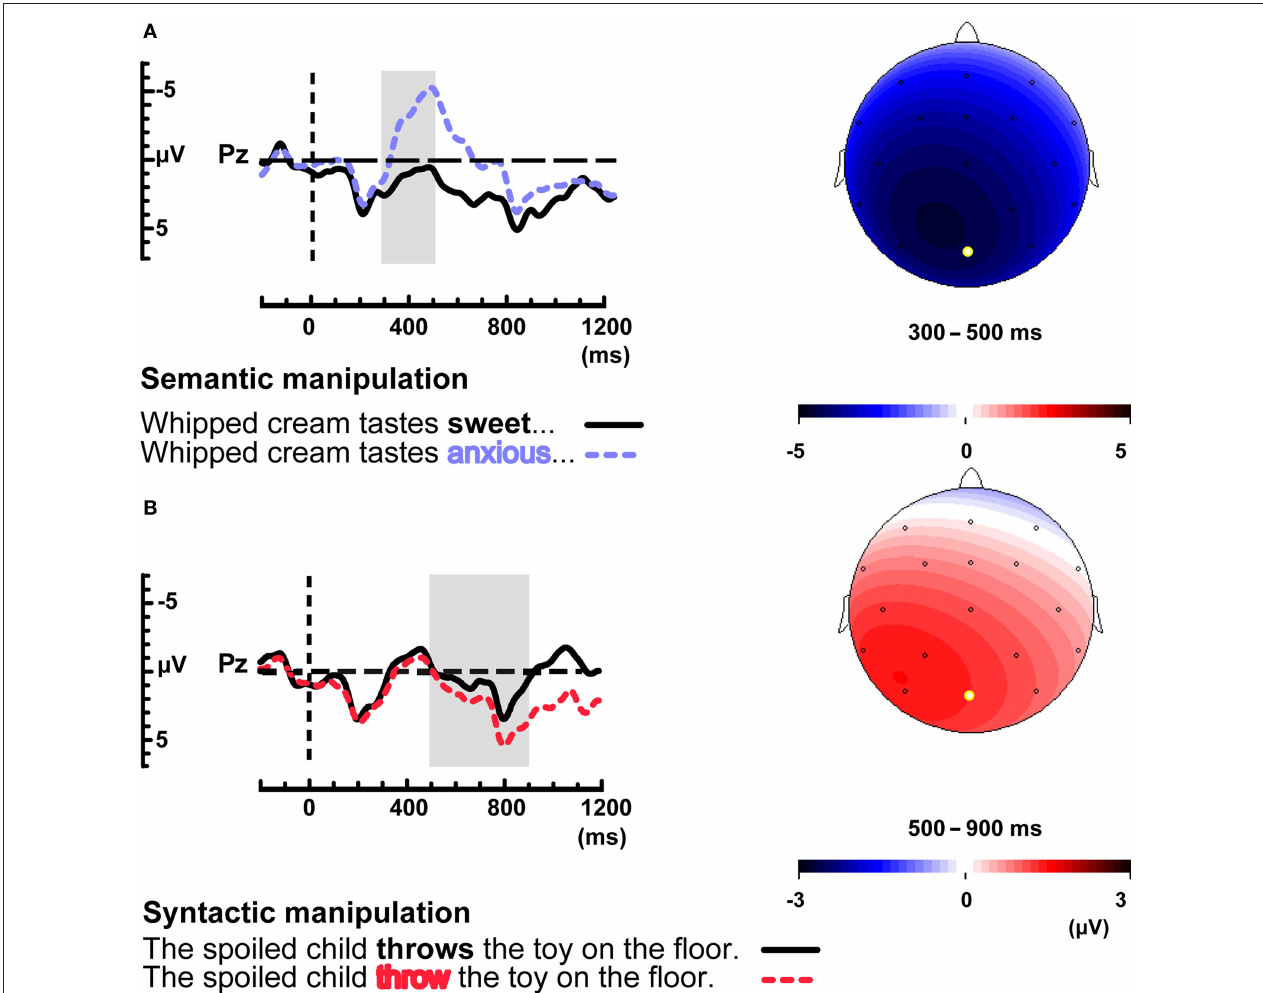
FiguRE 1 | (A) Grand-average waveforms for ERPs elicited by the semantic anomalies (dotted, blue line) and their correct controls (solid, black line) for electrode Pz and the scalp distribution of the N400 effect elicited by the semantic manipulation between 300 and 500 ms after critical word onset. (In this and all following figures the waveforms are time-locked to the onset of the critical word (0 ms) and negative voltage is plotted upward. Furthermore, an 8 Hz